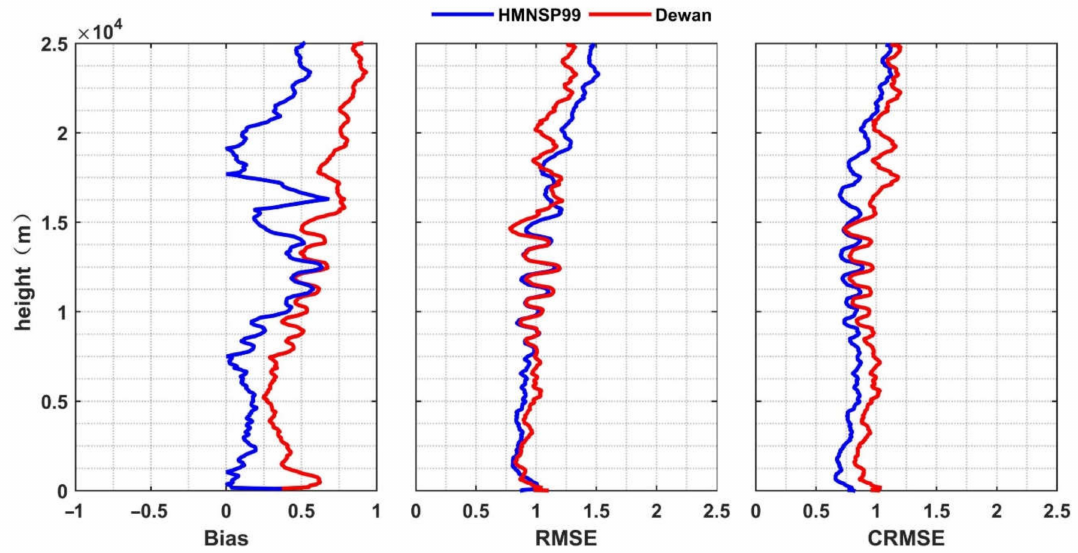
Figure 4. Overall statistical analysis of log C 2 n profiles of eighty-nine balloon